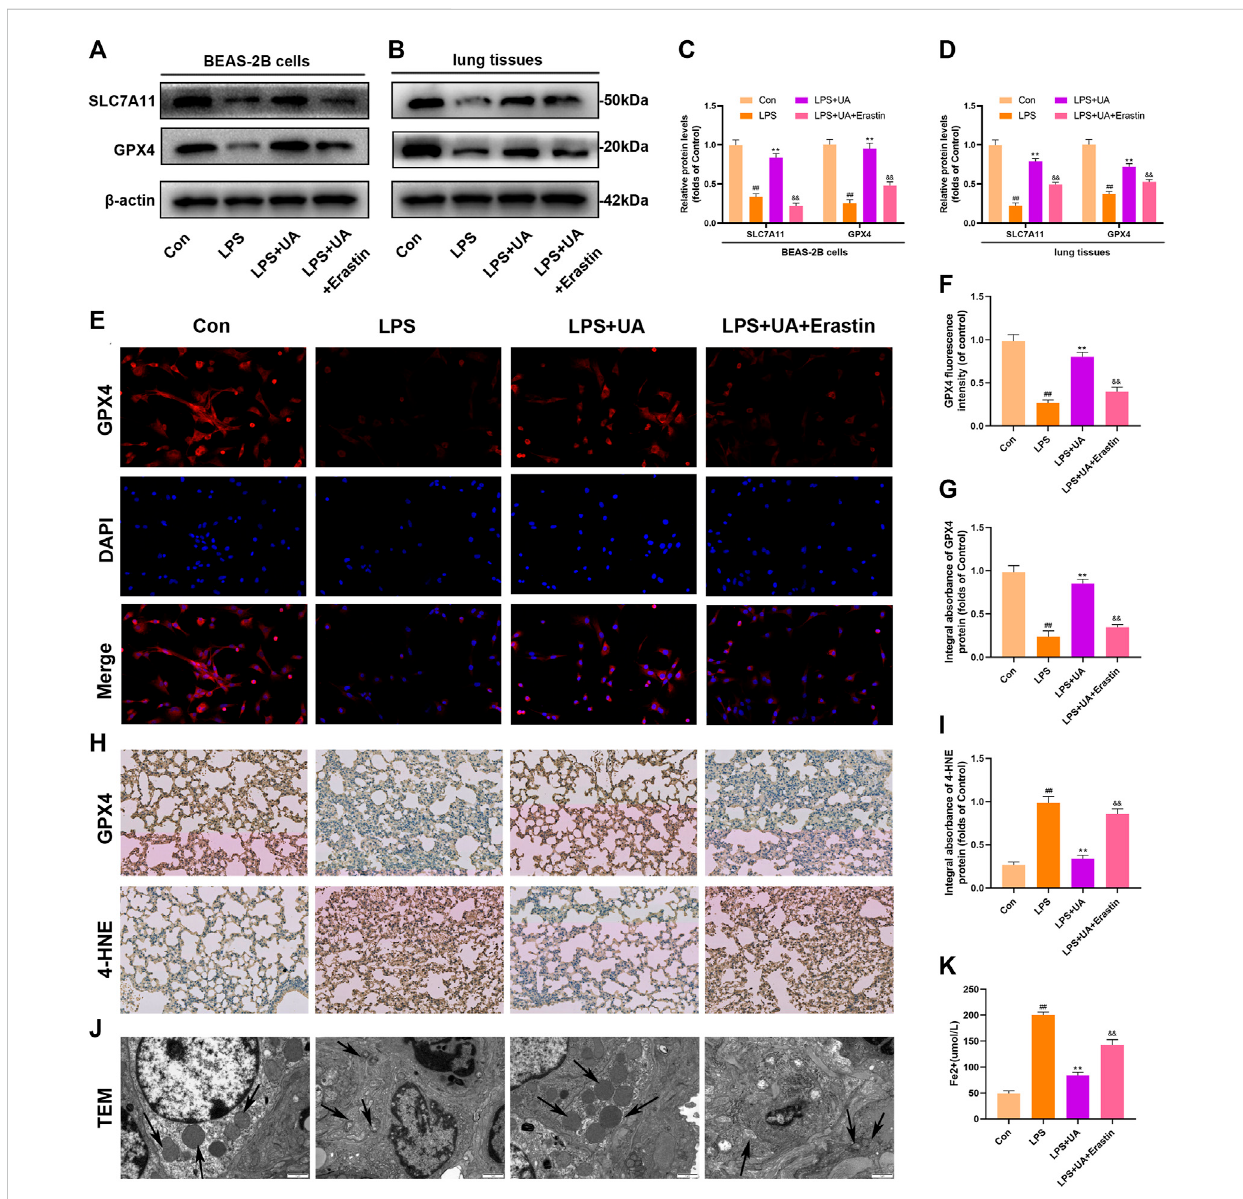
FIGURE 4 Role of UA in Ferroptosis during LPS-mediated injury in vitro and in vivo . (A,C) Levels of SLC7A11 and GPX4 in BEAS-2B cells were measured. (B,D) Quanti fi cation of SLC7A11and GPX4 levels inlung tissues. (E,F) Representative immuno fl uorescence images of GPX4 inBEAS-2B cells. (G – I) IHC images for GPX4 and 4-HNE expression in lung tissues. (J) Fe 2+ expression in BEAS-2B cells. (K) TEMimagedshowed ferroptosis of lung tissues. The results were represented by mean ± SD. ## p < 0.01, ** p < 0.01, && p < 0.01 in comparison with control, LPS and LPS + UA groups,